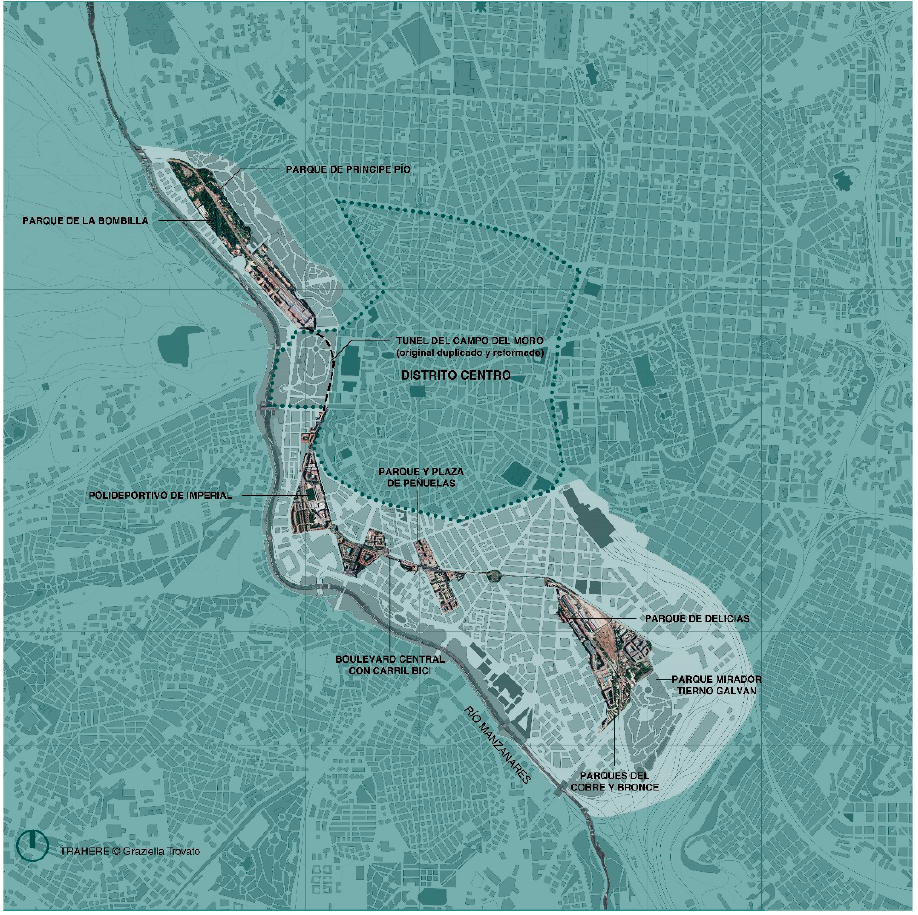
Figure 3. The PVF and the scope of action between the Central District of the capital and the Manzanares River. The parks of Príncipe Pío, Bombilla, Peñuelas, Delicias, Mirador de Tierno Galván, Cobre, and Bronce stand out, as well as the central boulevard with a bike lane. Source: TRAHERE’s own elaboration.